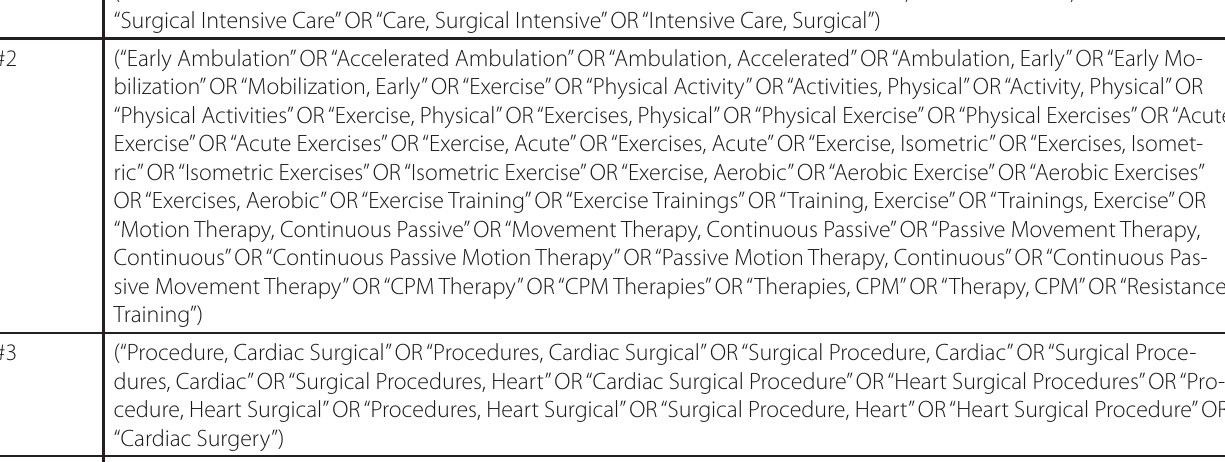
Table 1. Search strategy used in PubMed®.